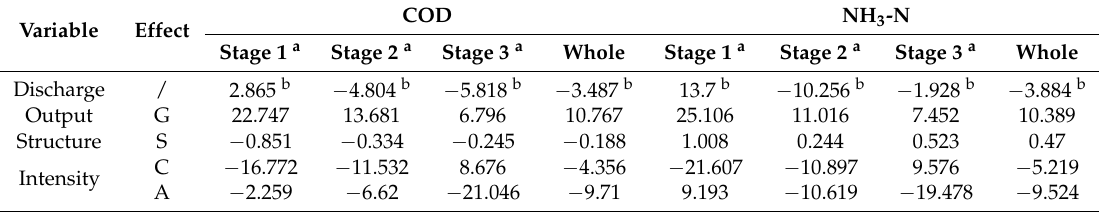
Table 2. Average annual contribution rates at various stages and for the entire study period